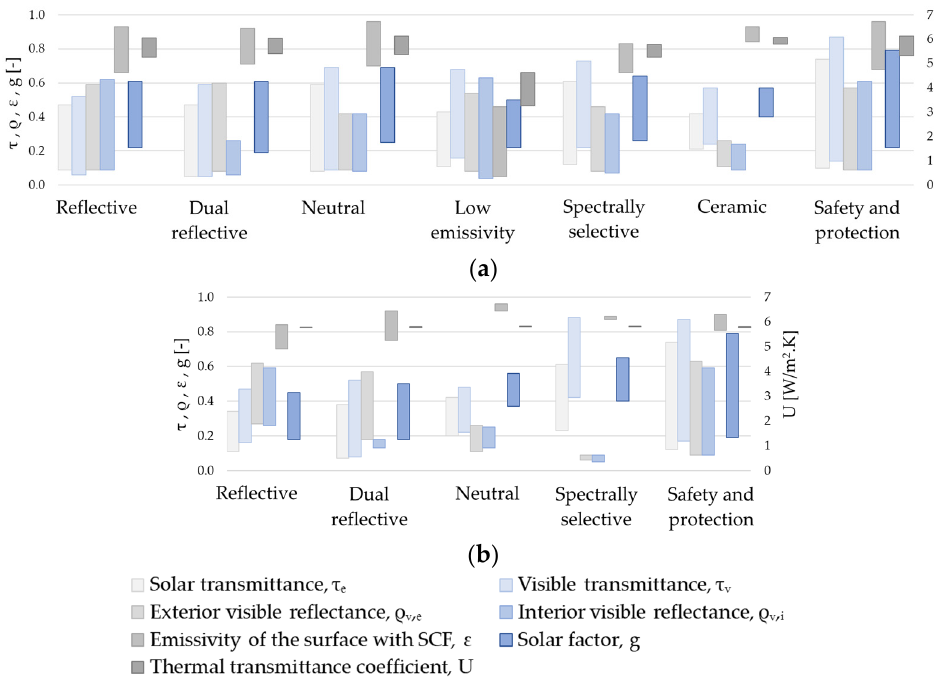
Figure 5. Ranges of values of the thermal and solar optical properties of glass and SCF systems, considering SCF is present in the IGDB database [31] when applied to the internal ( a ) and external ( b ) surface of a clear single glass (6 mm).